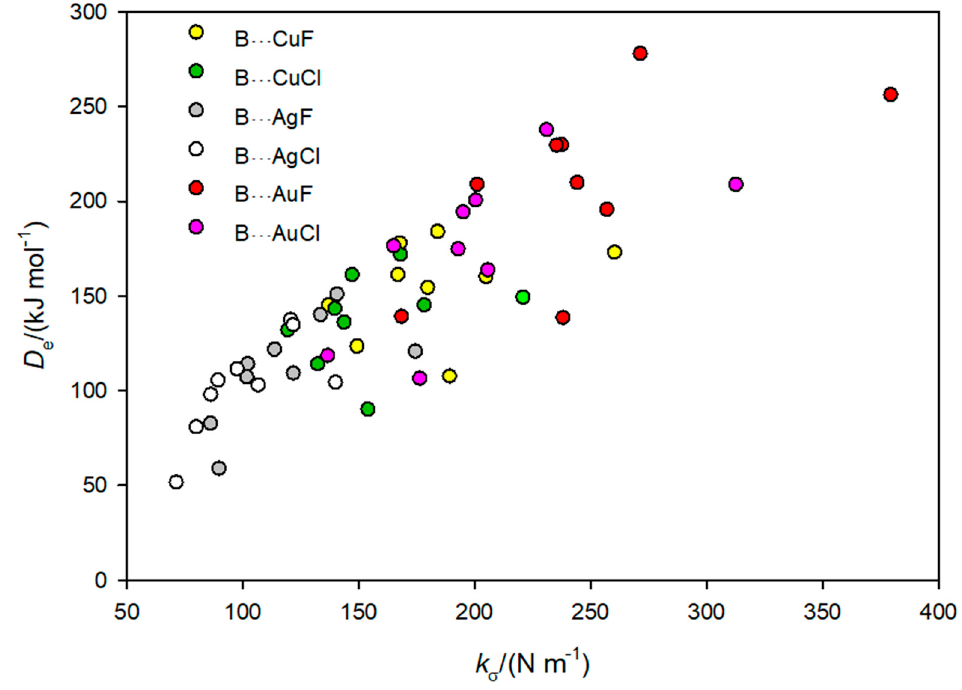
Figure 1. D e versus k σ for B · · · CuX, B · · · AgX, and B · · · AuX, where X = F and Cl. This diagram shows that there is no significant correlation between these two properties.